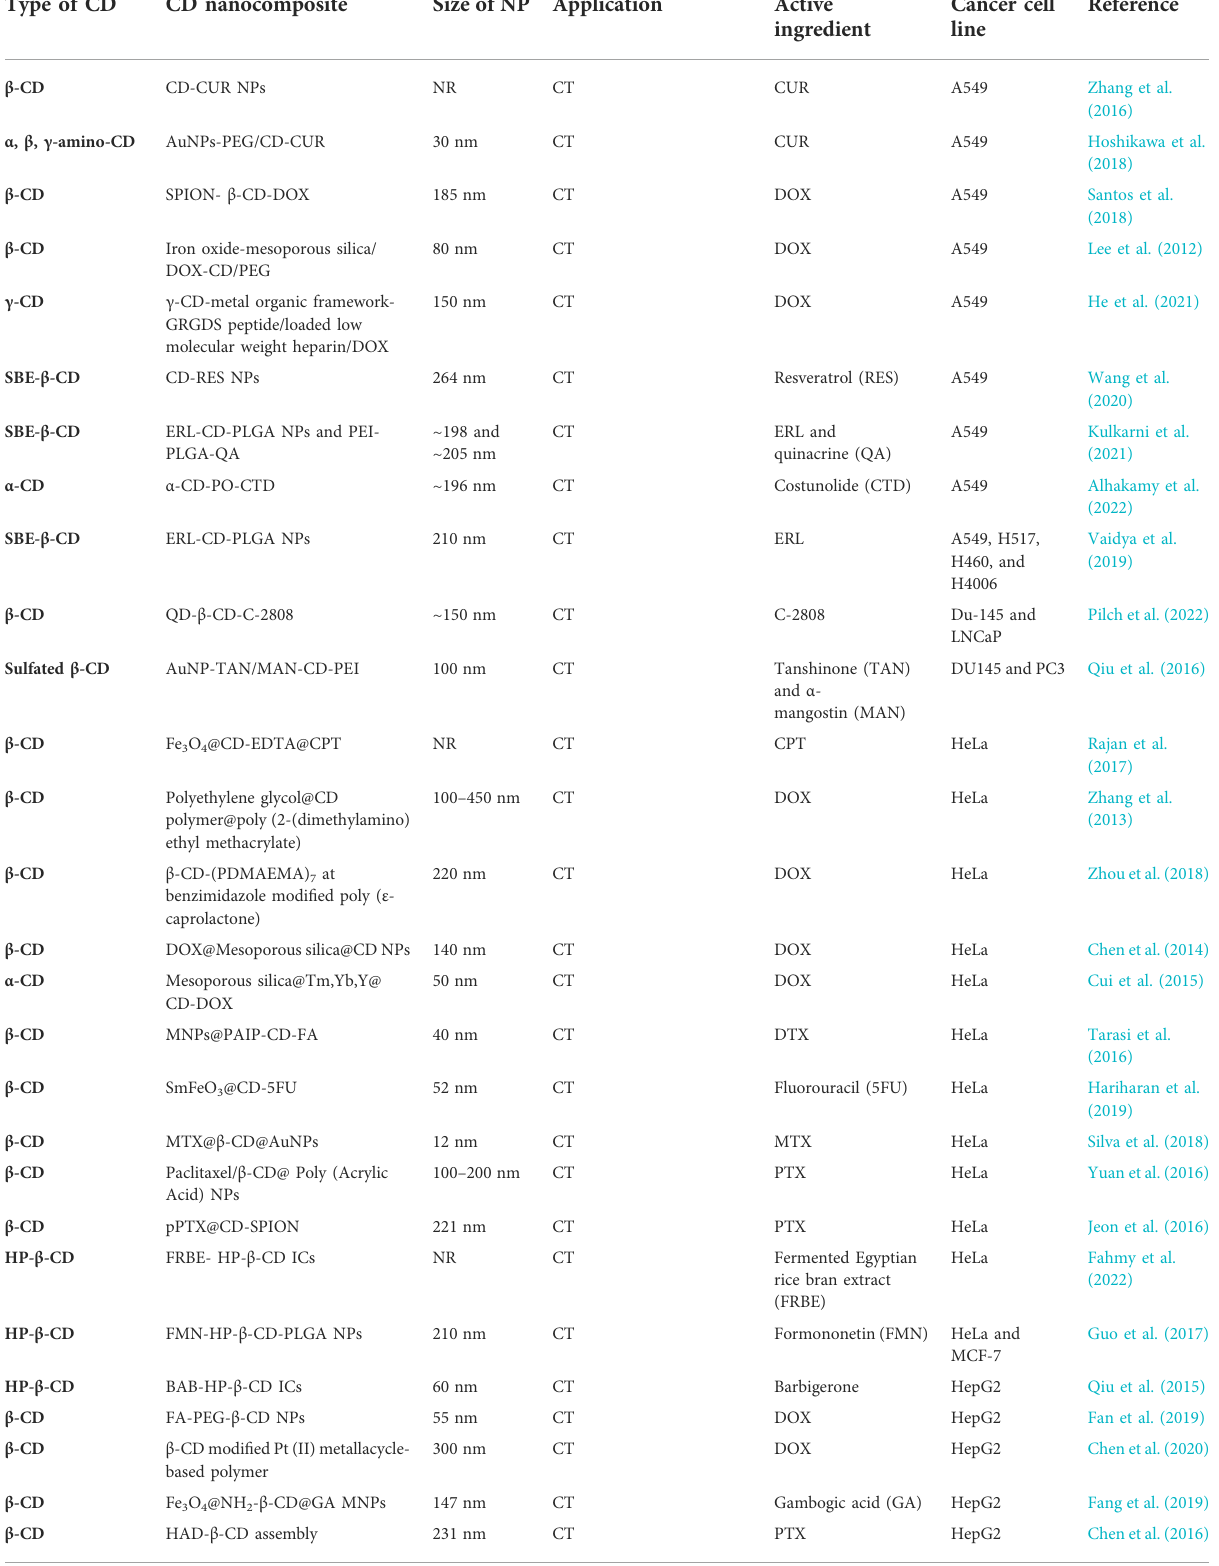
TABLE 1 Catalog of cyclodextrin nanocomposites and their applications in cancer